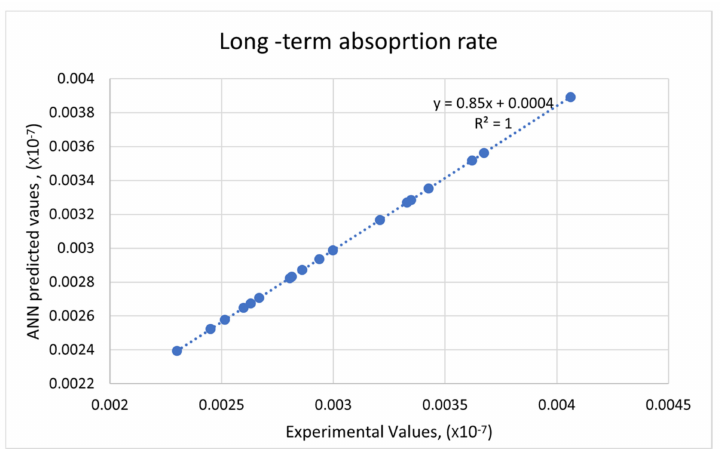
Figure 18. Long-term absorption rate—correlation between ANN and experimental values. Similarly, a graphical plot depicting the experimentally recorded and ANN predicted sorptivity rates for each of the 18 specimens used in this study is also displayed in Figures 19–21 below, describing the prediction accuracy of the ANN model.